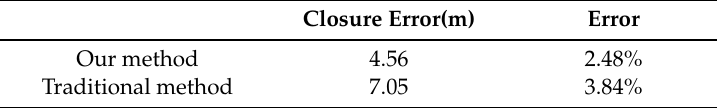
Table 4. Localization results of experiment II with a total length of 183.5 m.